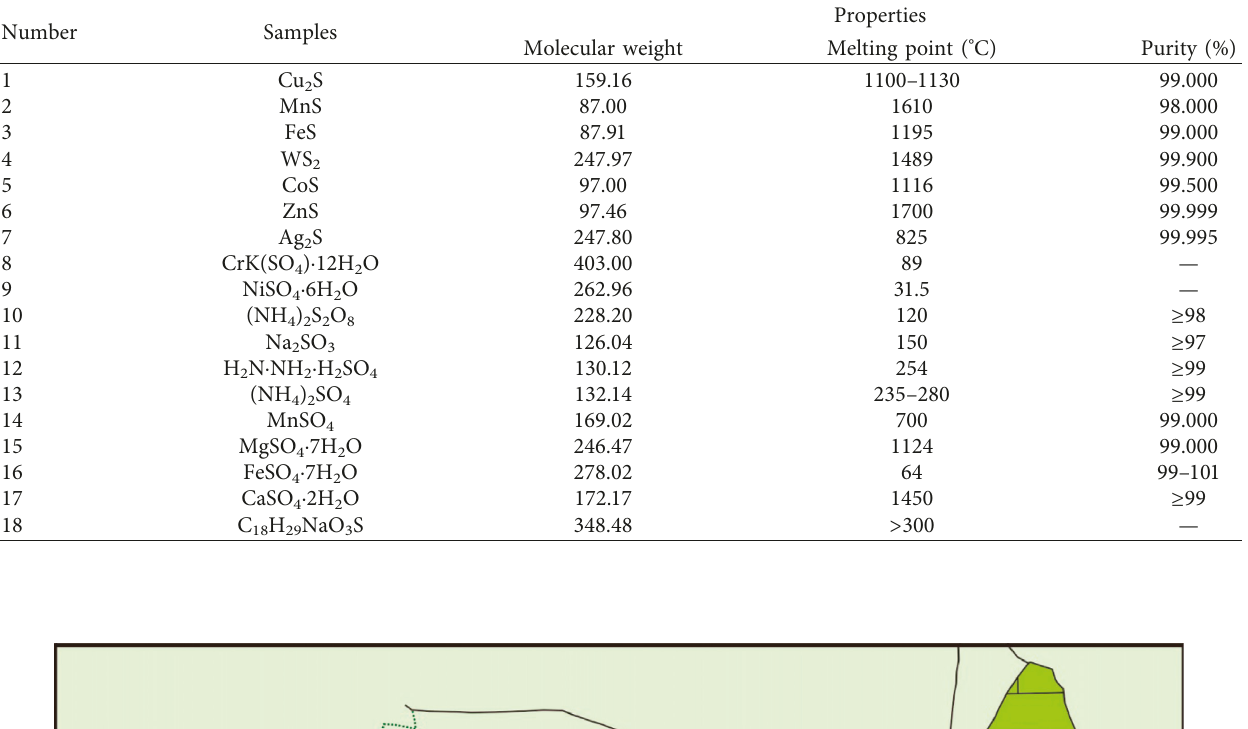
Table 1: Physical properties of sulfur species with known structures used in this work.